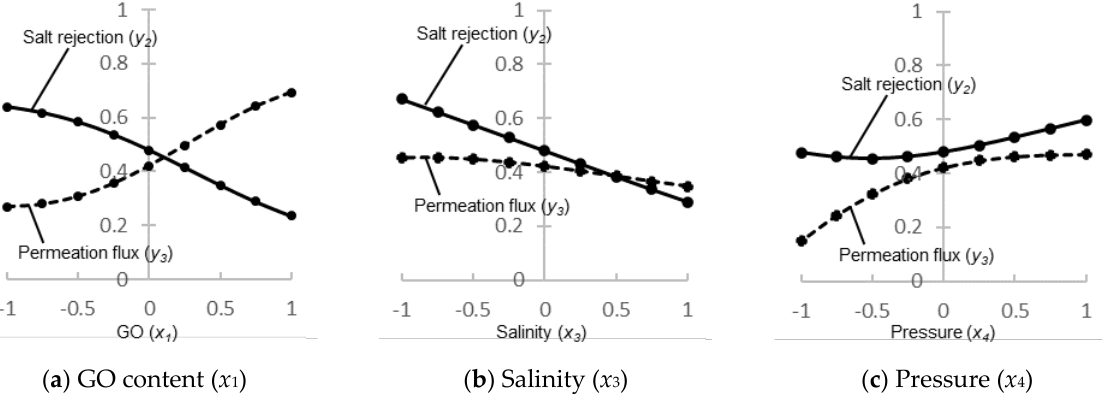
Figure 7. Output responses with respect to each input.